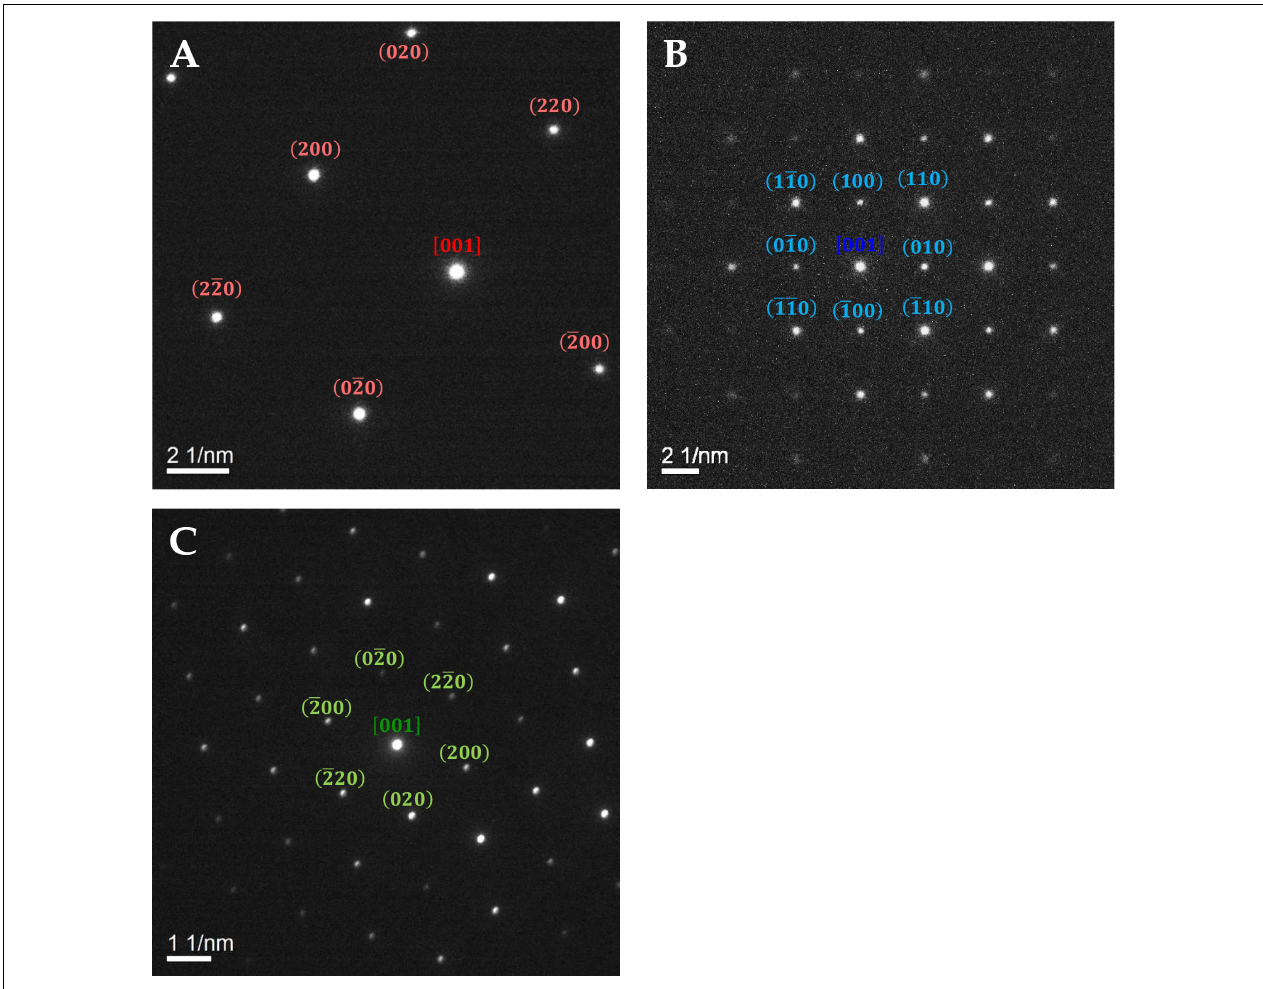
FIGURE 2 | SAED patterns in as-cast AlCrFe 2 Ni 2 alloy – obtained from (A) the FCC phase in zone axis (Z.A.) < 001 > ; (B) the B2 and BCC phases in Z.A. < 001 > and (C) the M 7 C 3 phase in Z.A. < 001 >